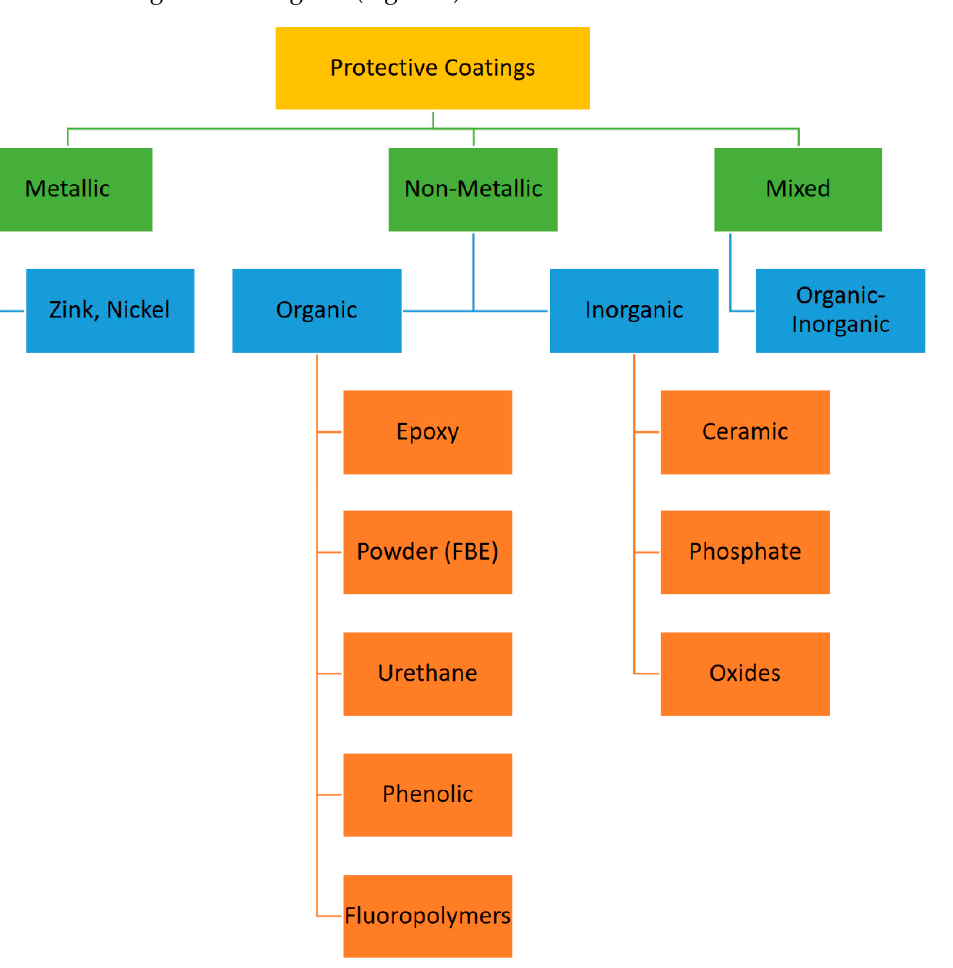
Figure 3. Types of protective coatings for downhole applications.